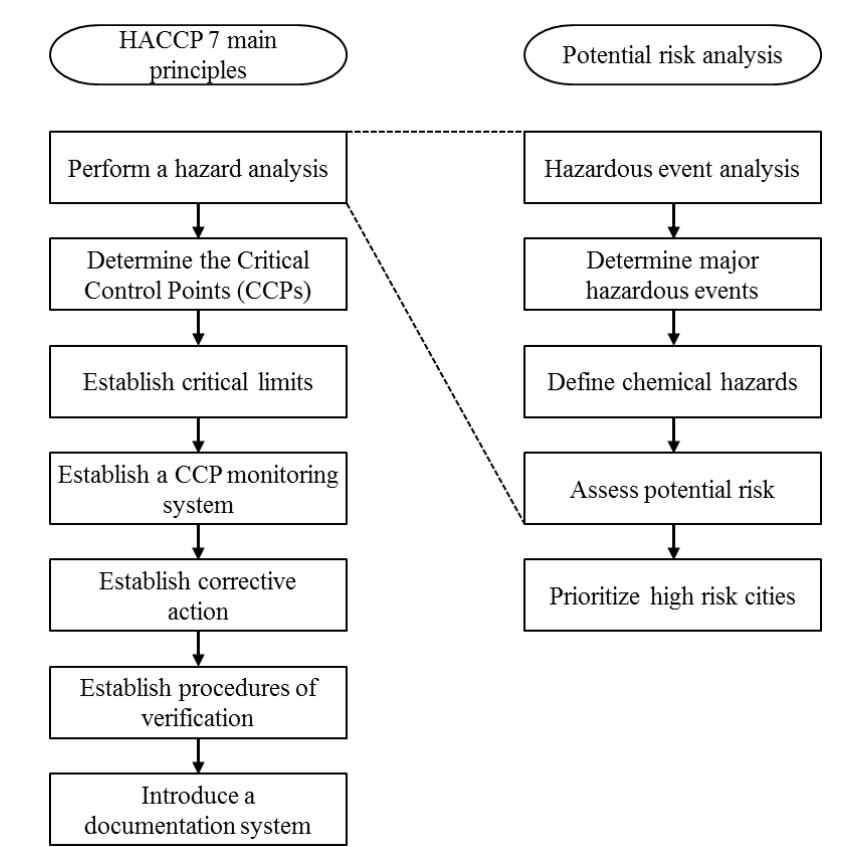
Figure 2. Relationship of hazard analysis and critical control points (HACCP) 7 principles and potential risk analysis.